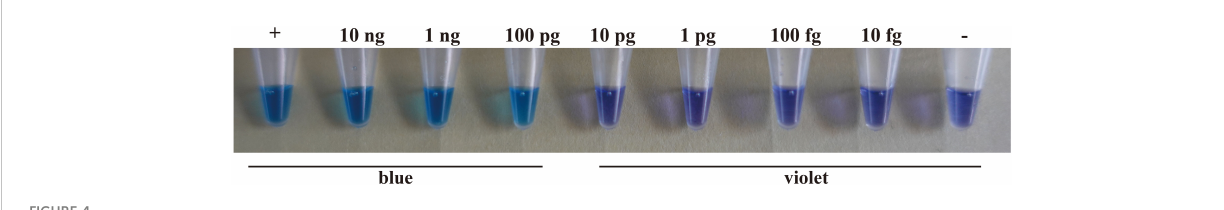
FIGURE 4 The sensitivity of the LAMP assay using a H. annosum s.s. 93961/6 DNA concentration gradient. “ + ” : positive control; “ - ” : negative control.